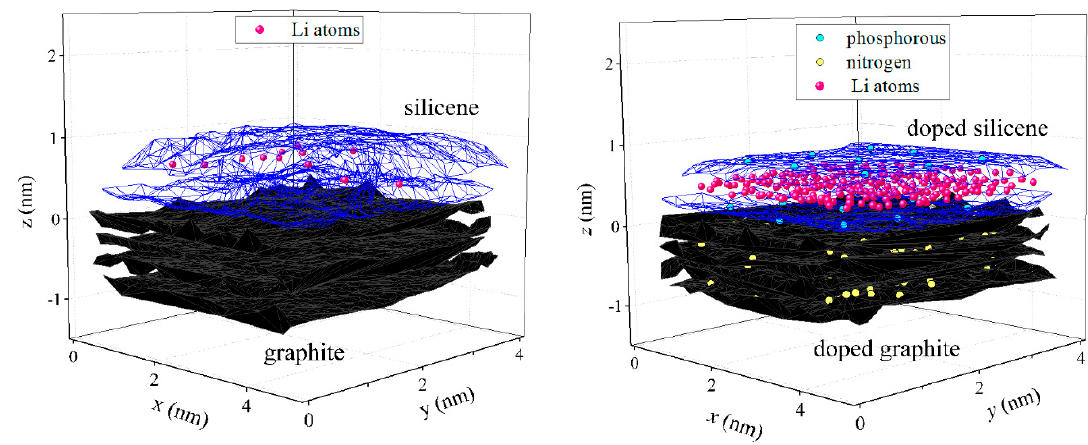
Figure 3. Filling of a silicene channel (gaps of 0.24 nm) with lithium on a graphite substrate after 500 ps. A pristine system is shown on the left, and a system subjected to nuclear transmutation doping is shown on the right.